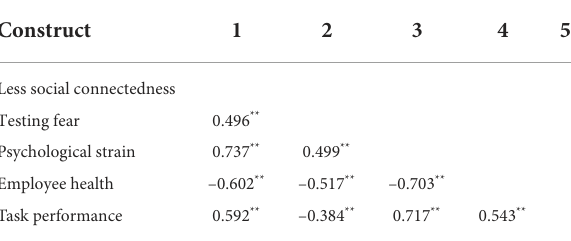
TABLE A1 Correlations among model